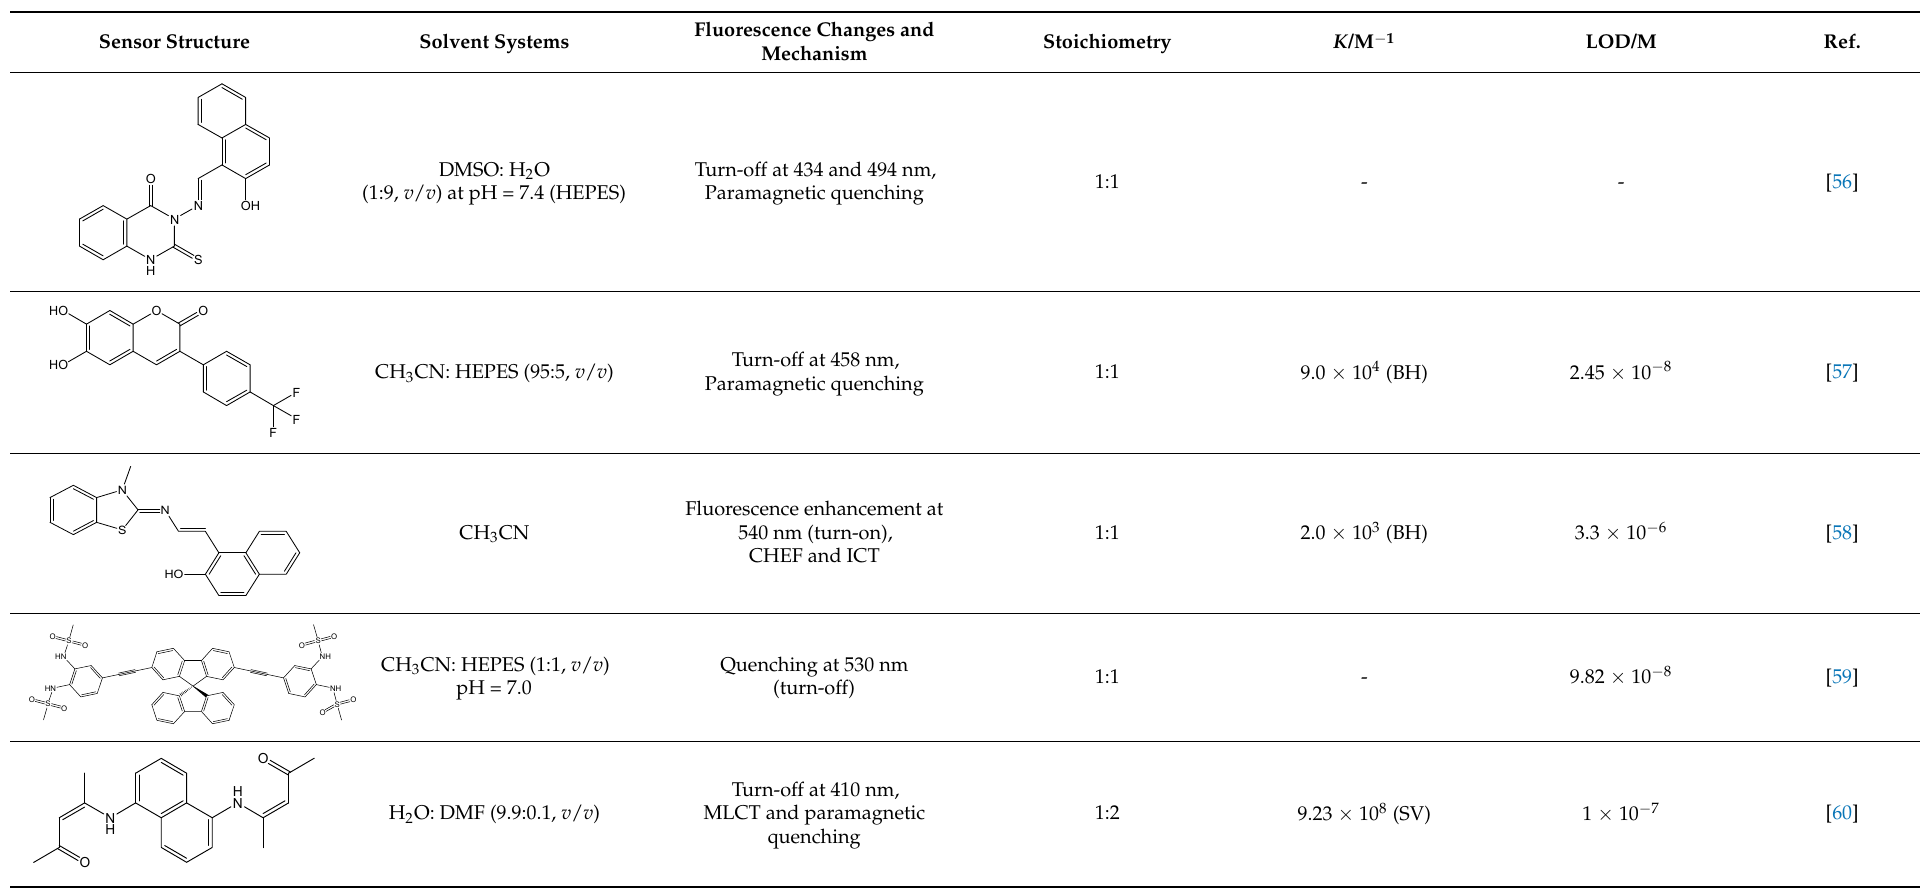
Table 2. Solvent systems, fluorescence changes, mechanism, stoichiometry (Ligand: Analyte), K and LOD values of sensors on complexation with Cu 2+ ions. Sensor Structure